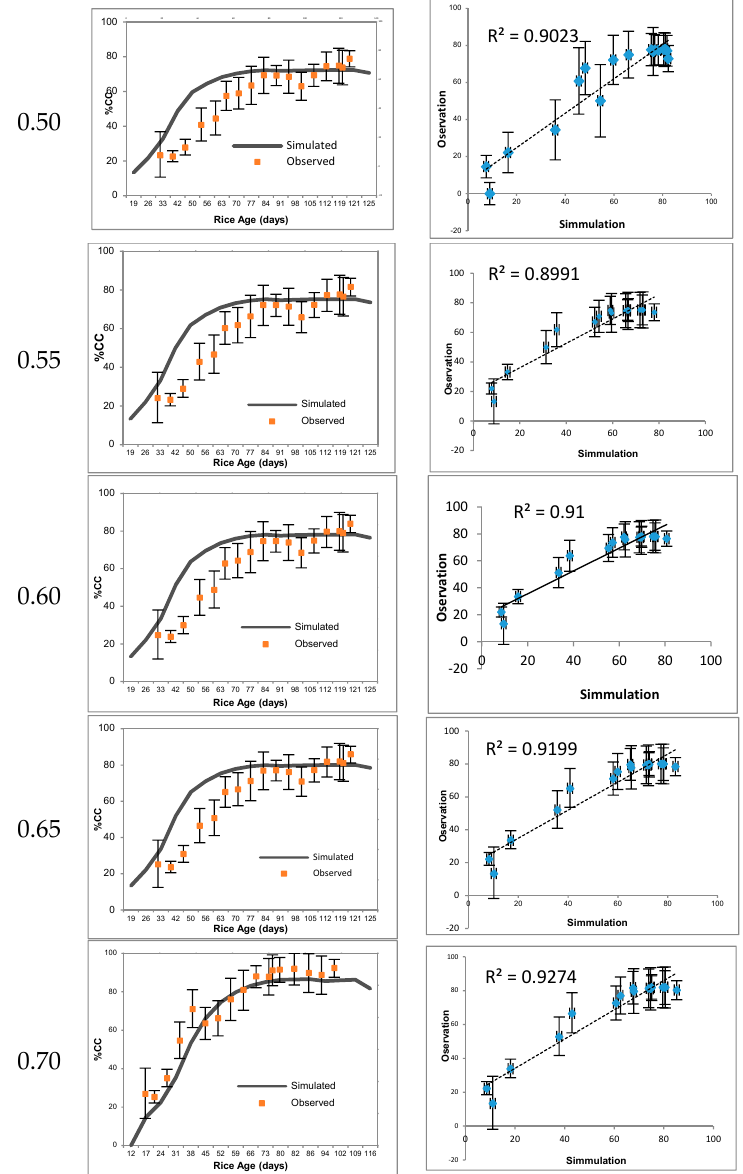
Figure 5. Graph and statistic display of the green canopy cover (CC) of machine transplanted rice (A); error bar represents the standard deviation of the observed CC.